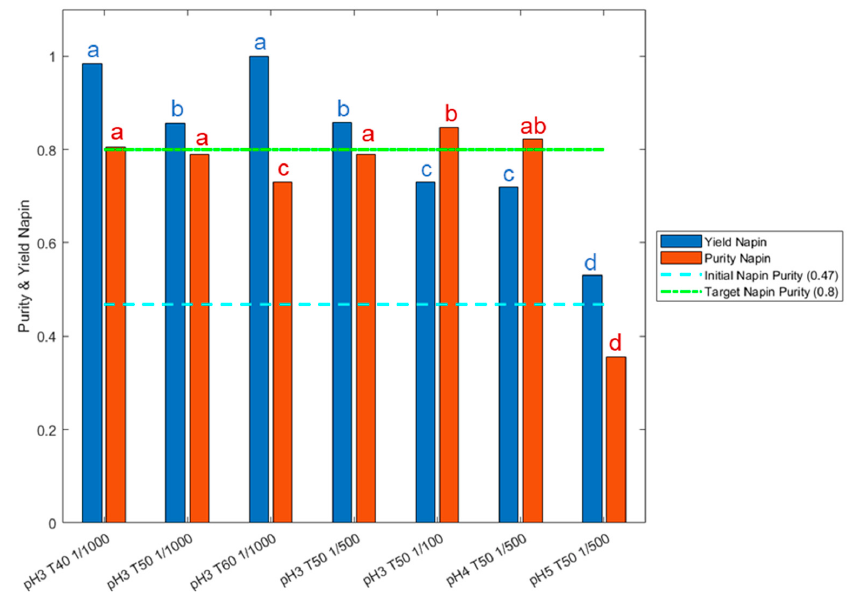
Figure 3. Napin purity (red bar and letters) and napin yield (blue bar and letters) quantification for hydrolysates obtained with Prolyve ® at 1% total rapeseed proteins ( w / v ) at pH range from 3.0 to 5.0, temperature from 40 to 60 °C and E/S ratio from 1/100 to 1/1000, after 5 h of hydrolysis. Statistically equivalent levels are under same letter.